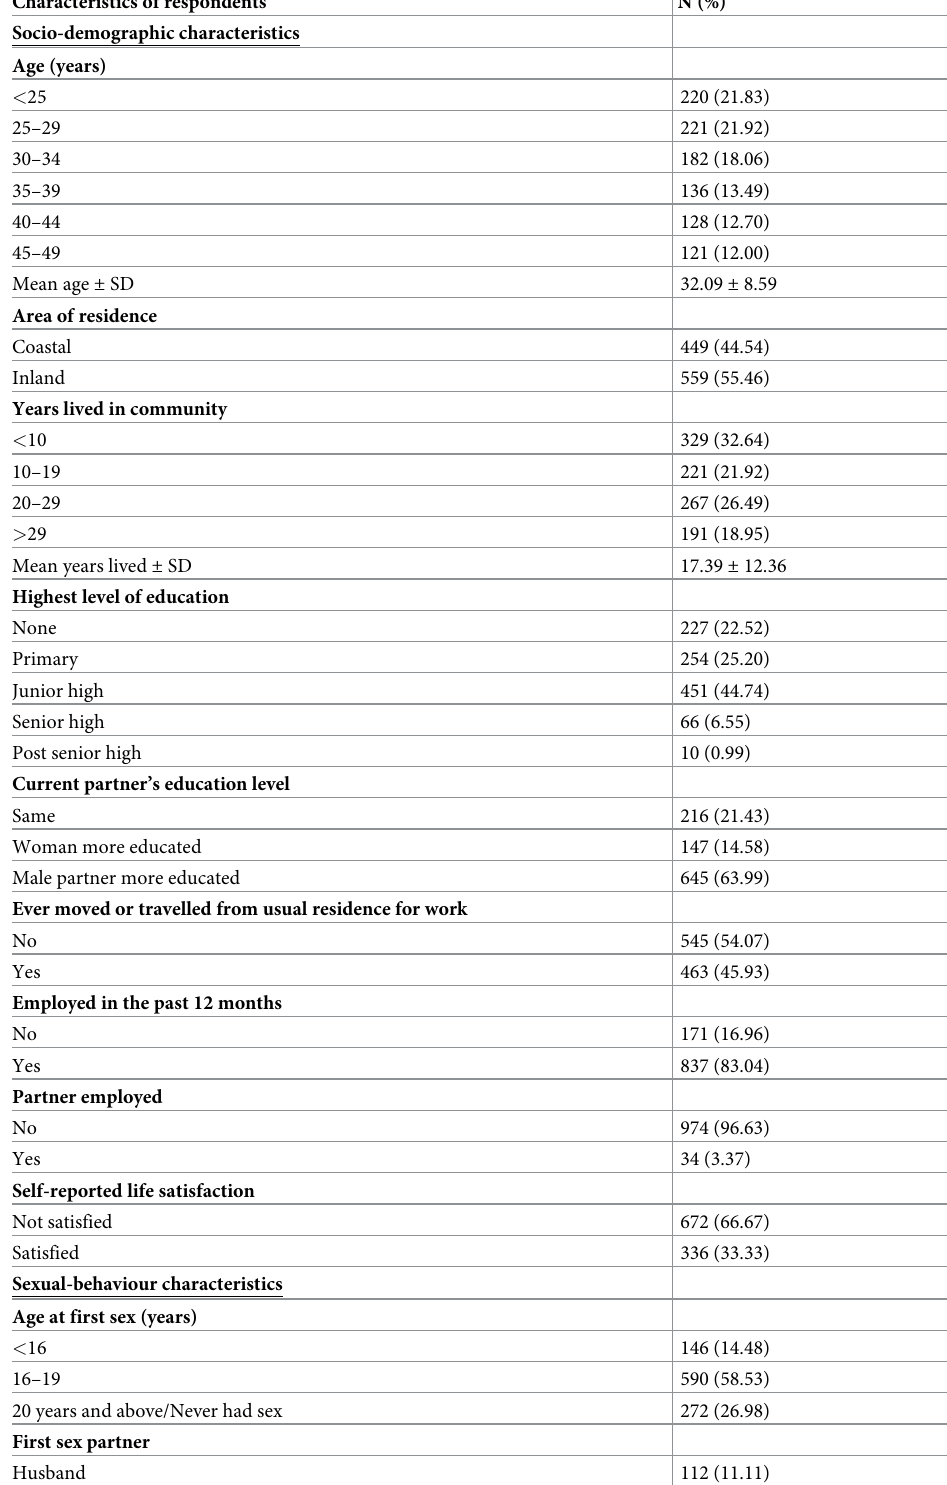
Table 1. Characteristics of study participants (N =